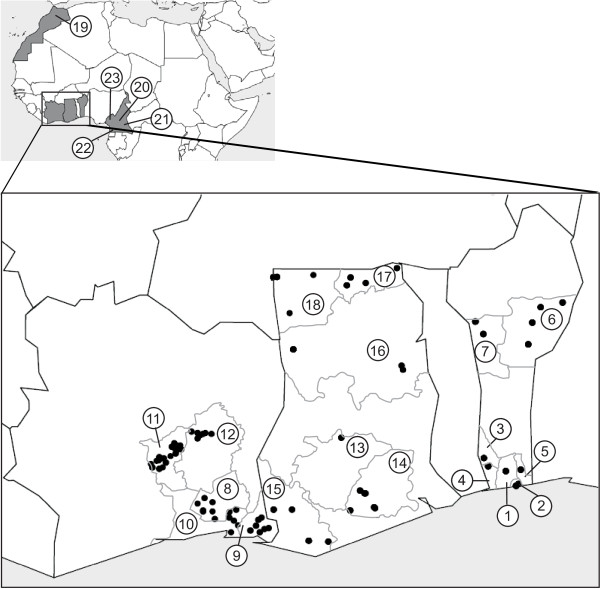
Geographic location of the 23 local chicken populations sampled throughout Côte d’Ivoire, Ghana, Benin, Cameroon and Morocco. Population units are numbered as indicated in Table 1. Dots represent collection sites for Benin, Ghana and Côte d’Ivoire.